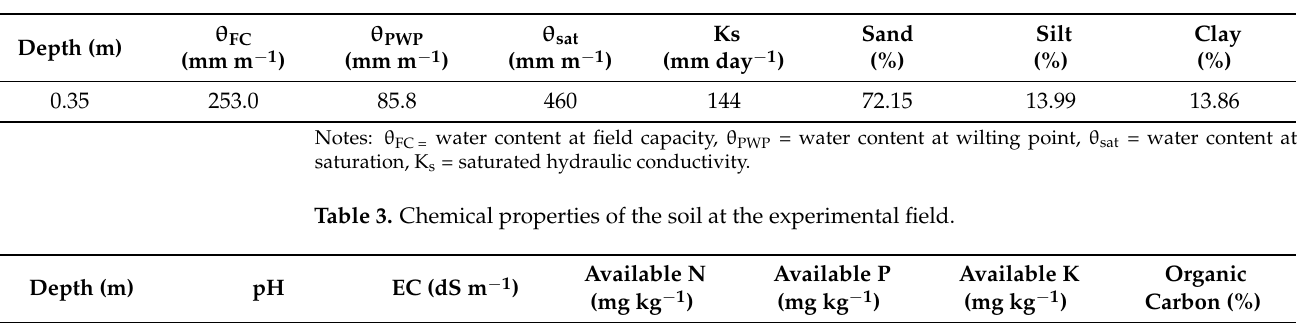
Table 2. Hydraulic properties of the soil at the experimental field.